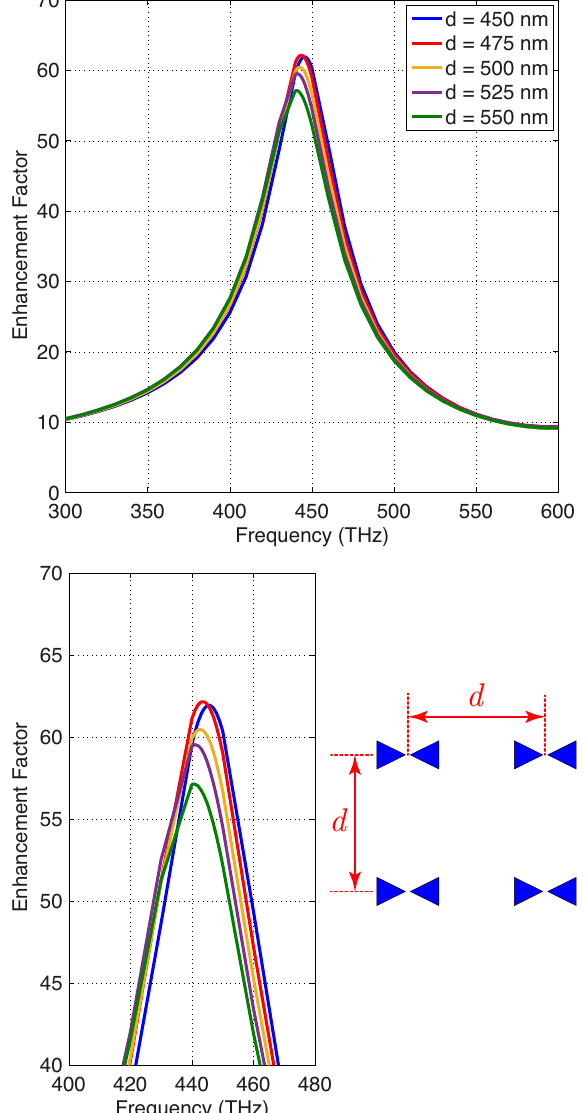
Figure 3: Power enhancement factor at the gap of an Ag bowtie nanoantenna in an arrangement of 2 × 2 nanoanten- nas with different periodicities.